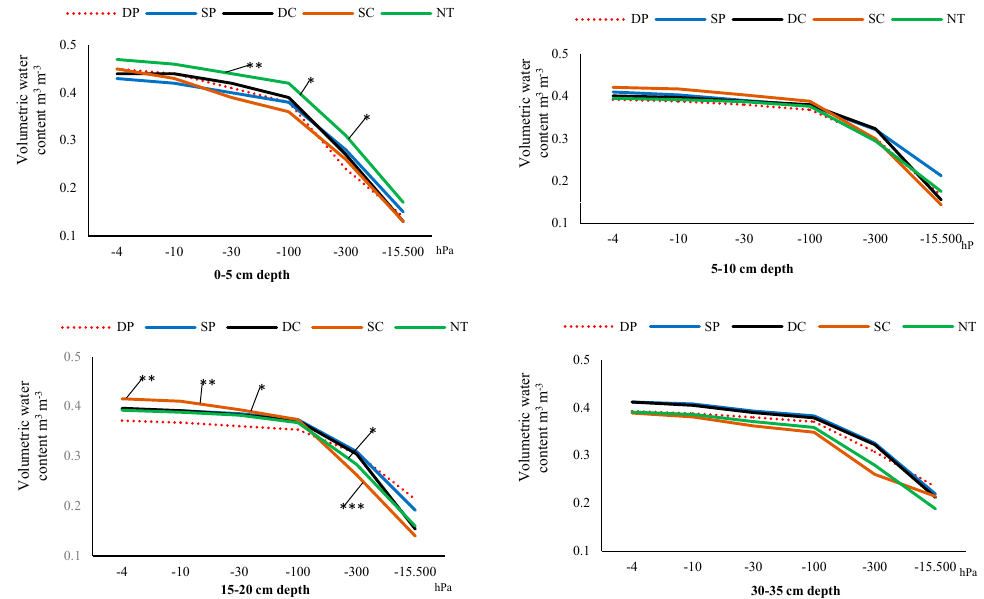
Figure 5. Effect of tillage intensity on soil water retention capacity in different soil layers, 2018. Notes: DP—deep ploughing (control treatment); SP—shallow ploughing; DC—deep cultivation; SC—shallow cultivation; NT—no tillage (direct drilling). *—significant difference at 0.01 < p ≤ 0.05; **—at 0.001 < p ≤ 0.01; ***—at p ≤ 0.001; p > 0.05—no significant difference compared to the DP. The significance of data was determined by Fisher’s least significant difference (LSD) test.